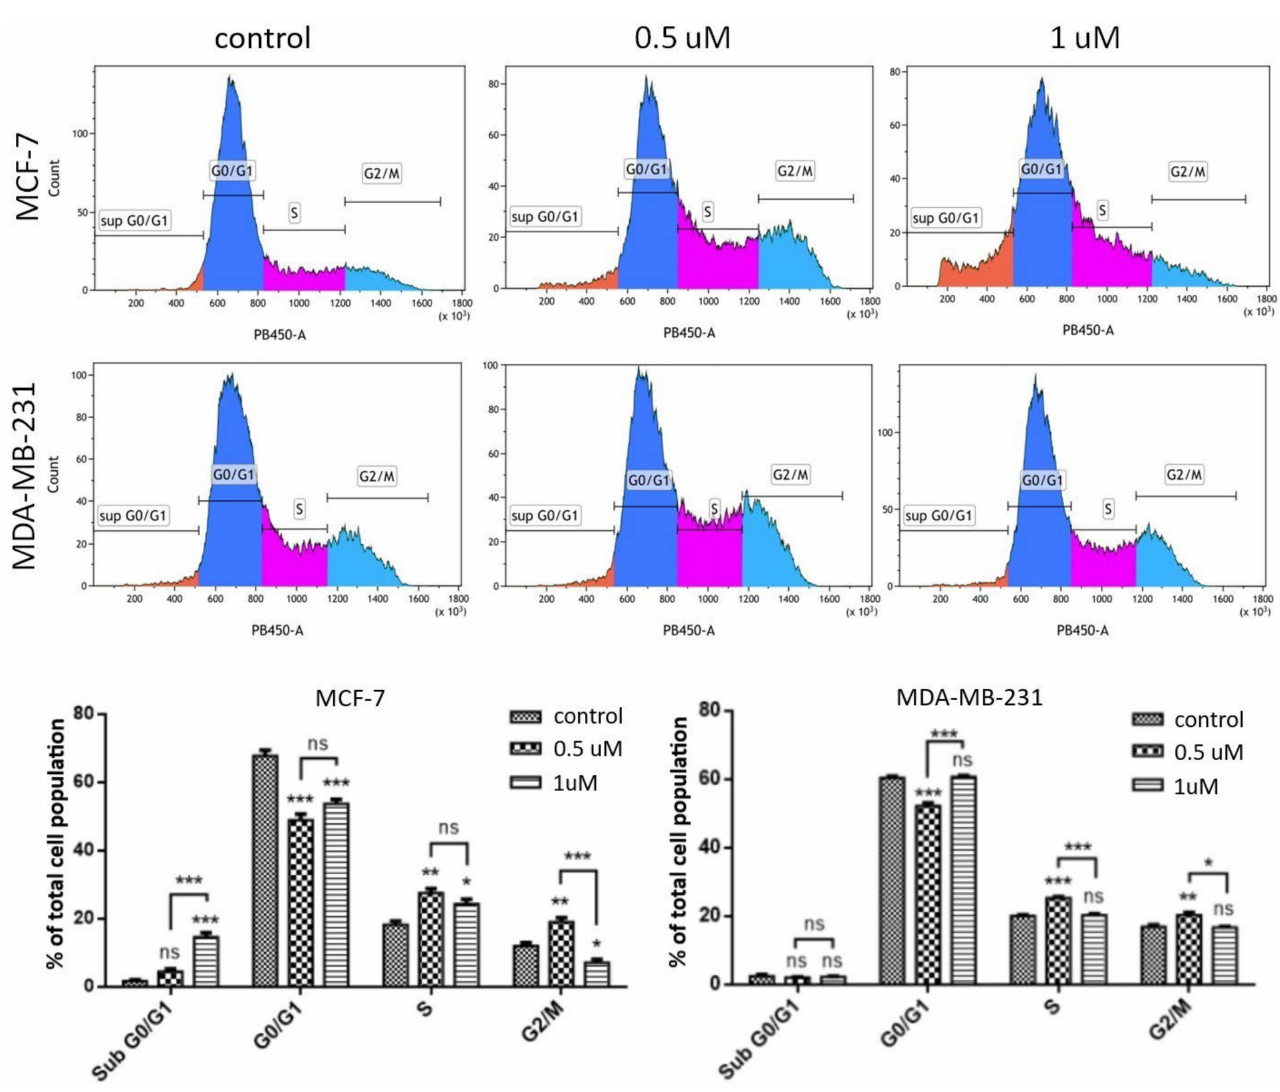
Figure 8. Effect of AJ-418 on cell cycle distribution in MCF-7 and MDA-MB-231 cells. Cells were exposed to AJ-418 at 0.5 µ M and 1 µ M concentrations for 24 h, stained with DAPI and analyzed using flow cytometry. Representative histograms and quantification are shown in the figure; error bars represent means ± SEM of three replicates. * p < 0.05, ** p < 0.01 and *** p < 0.001 were considered statistically significant compared to controls, ns—no statistical